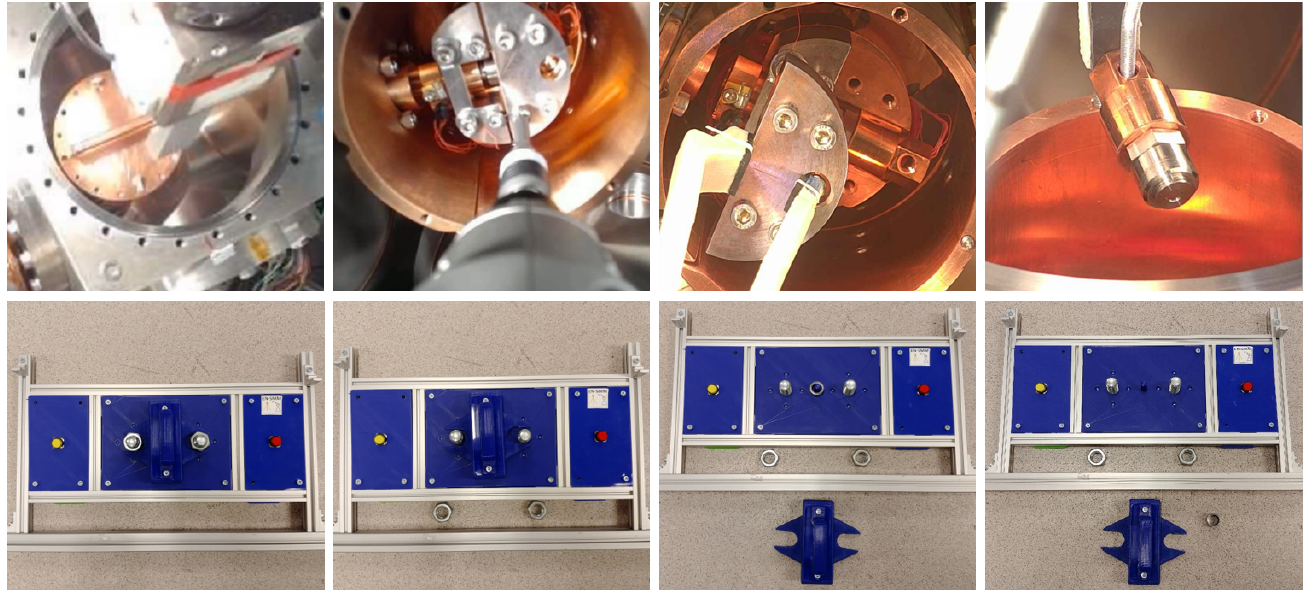
Figure 2. (First row) Antimatter factory real intervention performed by the CERN-EN-SMM-MRO team to recover a radioactive source; (Second row) Educational Mockup simulating the necessary steps to recover a